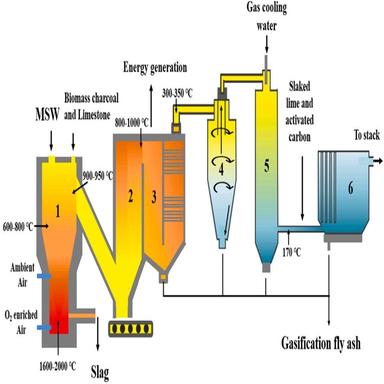
The process of MSW slagging-gasification (a) and conventional MSW incineration (b).